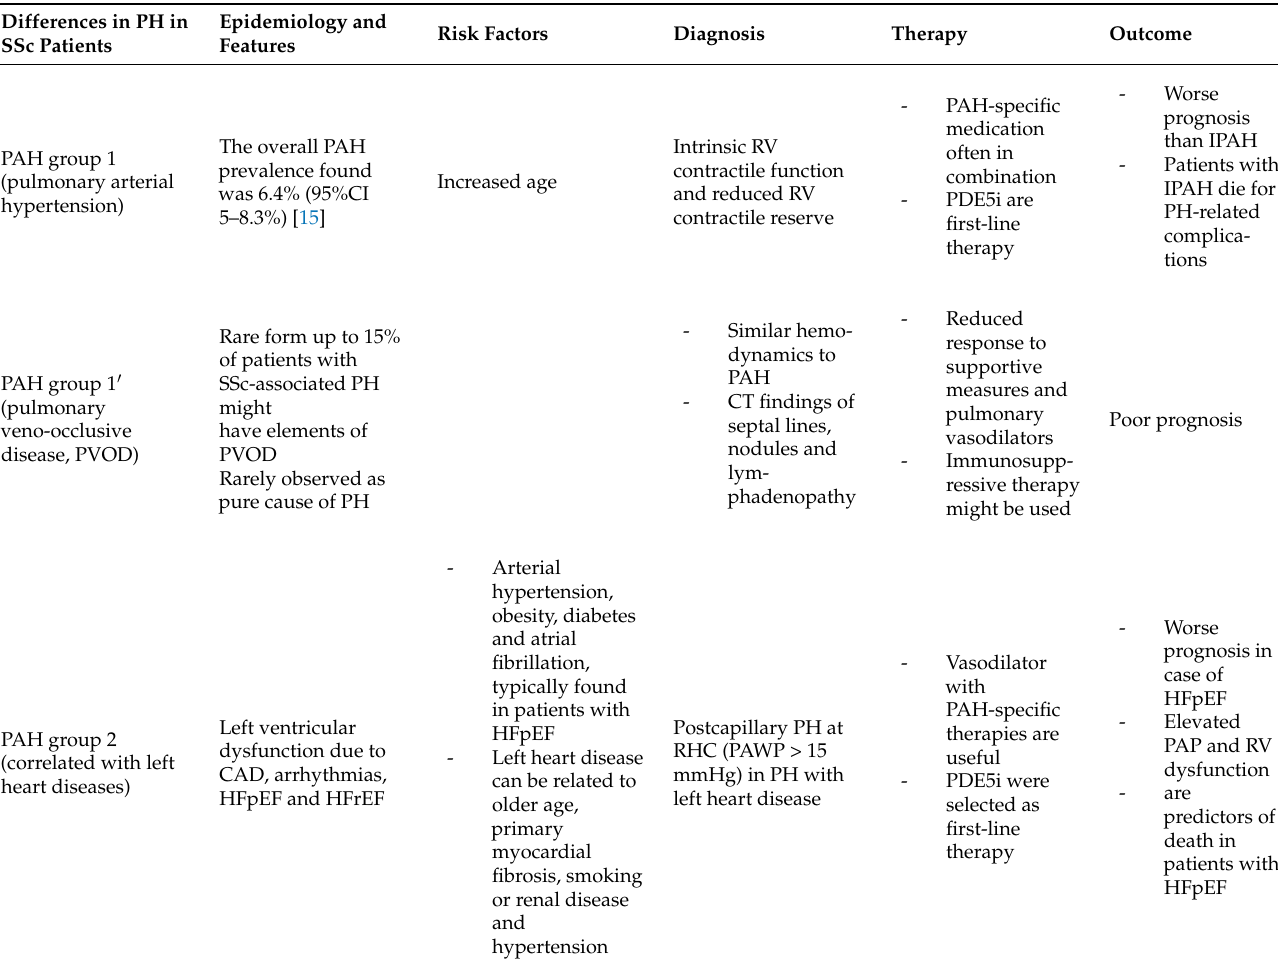
Table 1. Different phenotypes of PH in SSc